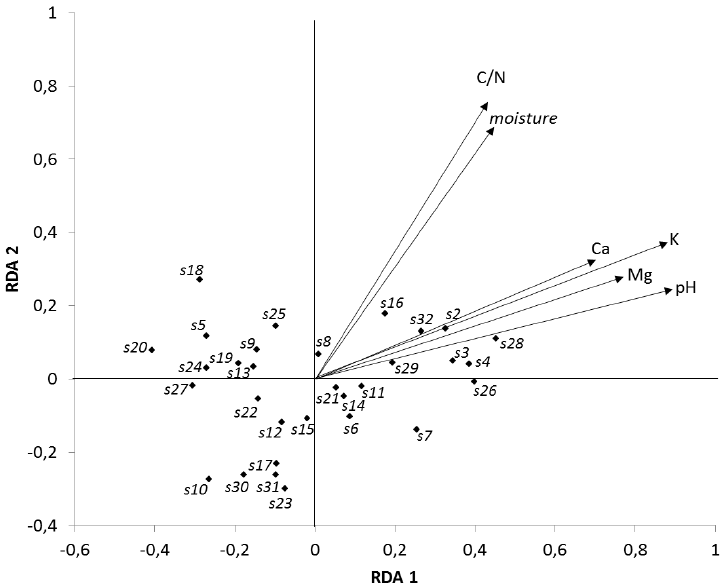
Figure 4. Redundancy analysis (RDA) of soil microbial data: functional groups positions and significant environmental variables which passed the forward selection. Arrow tips instead of complete arrows show the positions of functional microbial groups (metabolizing specific substrates): s2, β -methyl- D -glucoside; s3, D -galactonic acid γ -lactone; s4, L -arginine; s5, pyruvic acid methyl ester; s6, D -xylose; s7, D -galacturonic acid; s8, L -asparagine; s9, Tween 40; s10, i-erythritol; s11, 2- hydroxybenzoic acid; s12, L -phenylalanine; s13, Tween 80; s14, D -mannitol; s15, 4-hydroxybenzoic acid; s16, L - serine; s17, α -cyclodextrin; s18, N -acetyl- D - glucosamine; s19, γ -hydroxybutyric acid; s20,